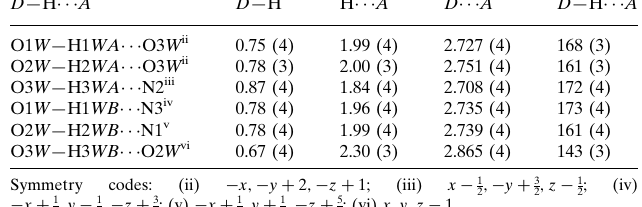
For transition metal complexes of 4-quinolinecarboxylic acid, see: Bu et al. (2005); Chen et al. (2002); Morsy & Vratislav